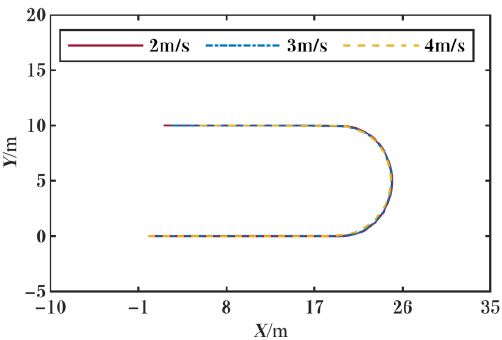
Figure 9. The trajectory of the simulation at different speeds.